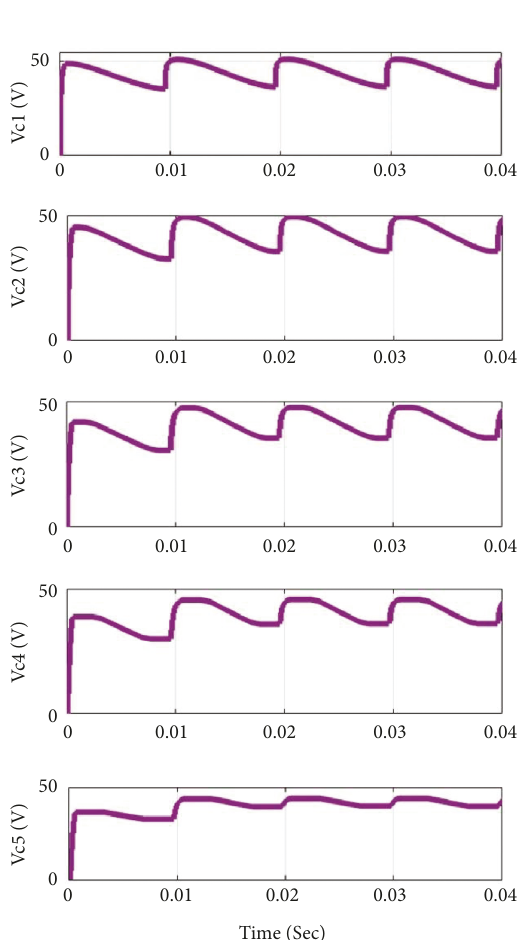
Figure 6: Withstanding voltages of